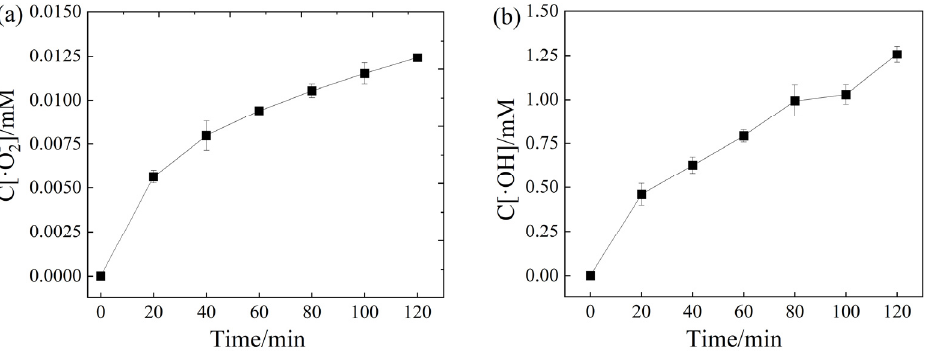
Figure 7. The concentration of ROS generated under irradiation in the presence of 0.3-Zn/Bi compo- site photocatalyst: ( a ) ·O 2 − ; ( b ) ·OH.